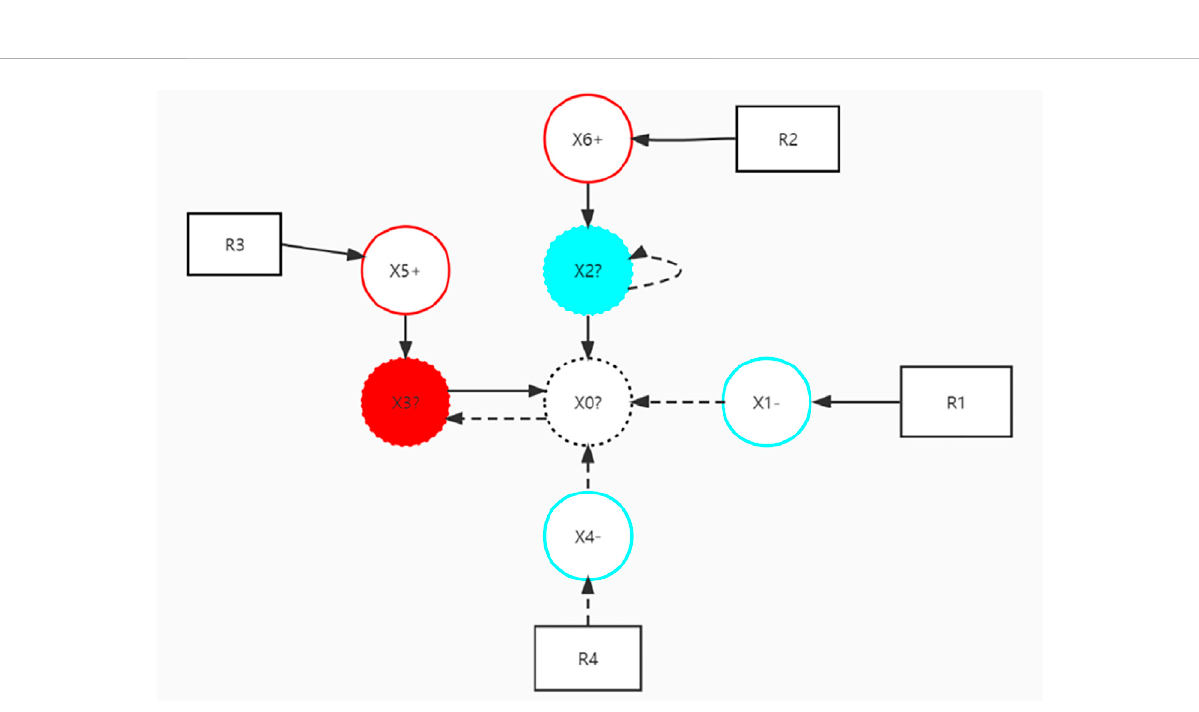
FIGURE 5 SDG intermediate transient